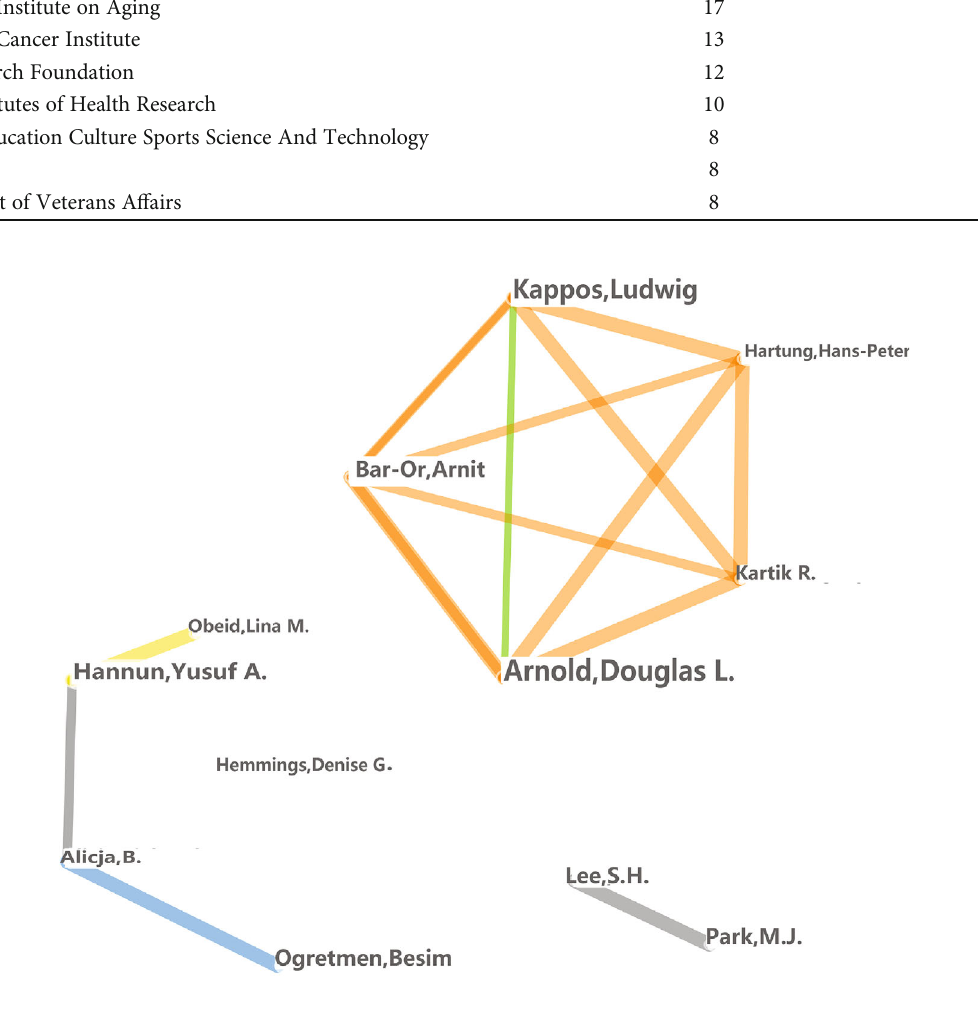
Figure 5: Cooperation network describing the relationships between the most productive researchers in S1P and age-related